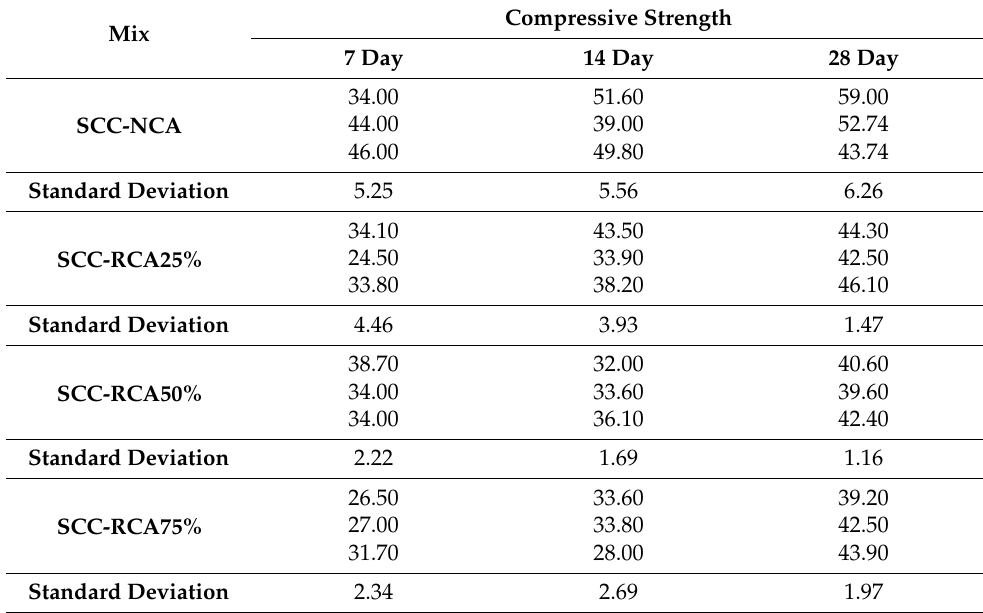
Table 4. Compressive strength deviation assessment.